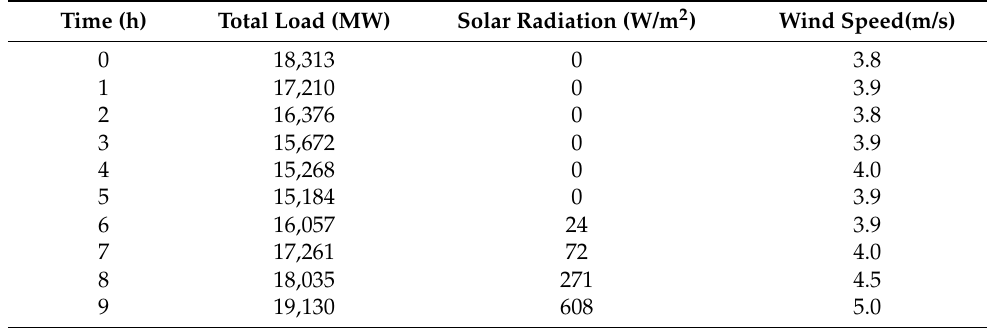
Table 2. Winter daily load, solar radiation and wind speed in